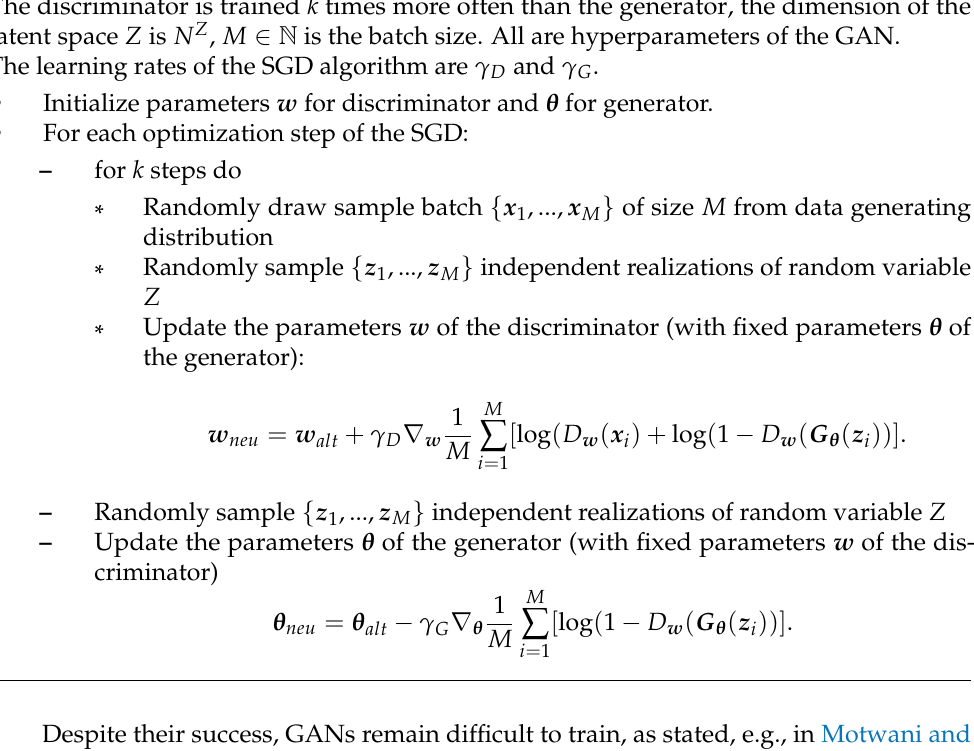
Algorithm 1 Algorithm for GAN training with SGD (stochastic gradient descent) as